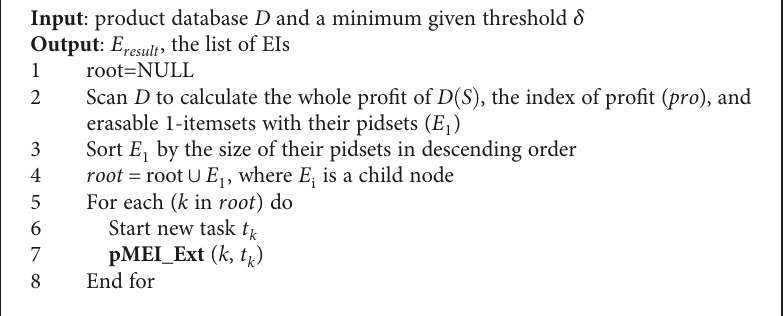
Algorithm 1: pMEI method.